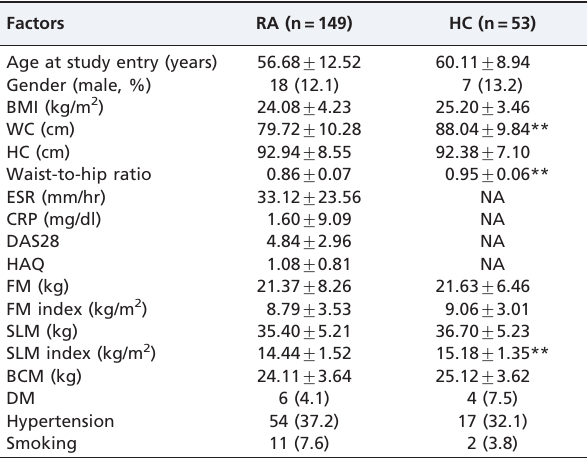
Table 1 - Demographic data, comorbidities and body compositions of 149 patients with rheumatoid arthritis (RA) and 53 unrelated healthy control subjects (HC) # .